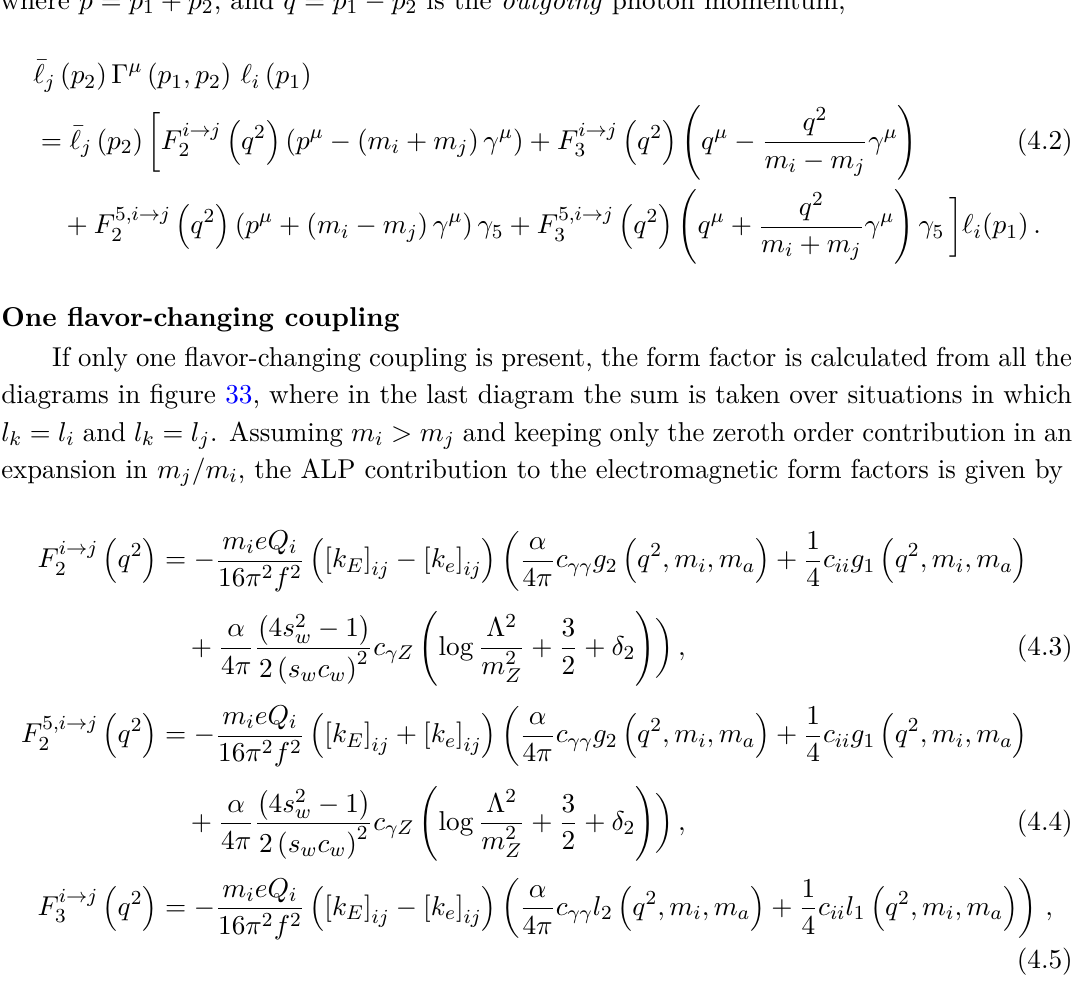
( q 2 ) and F (5) ,i → j ( q 2 ) as 2 3